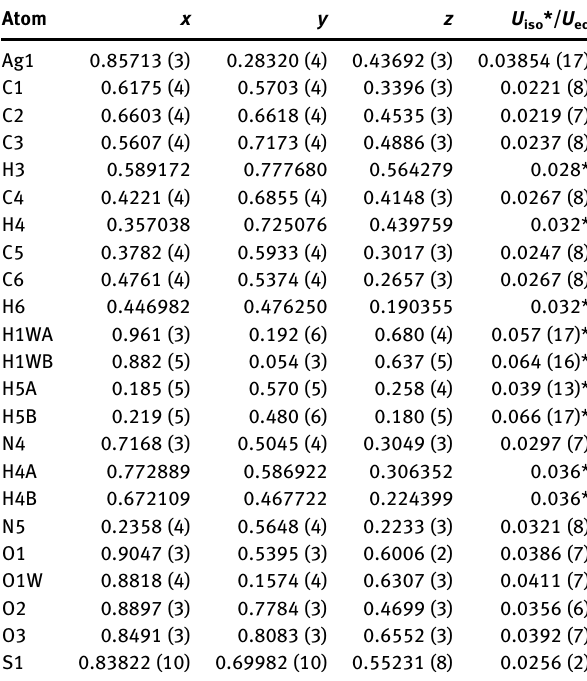
Table  : Fractional atomic coordinates and isotropic or equivalent isotropic displacement parameters (Å 